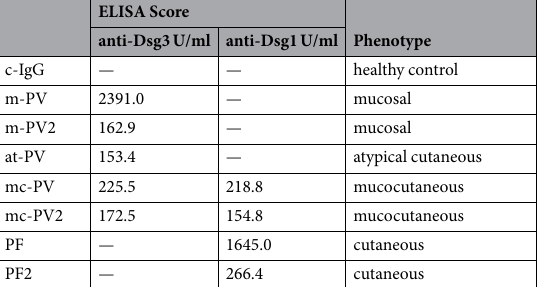
Table 1. Antibody profiles of IgG-fractions determined by Dsg1 and Dsg3 ELISA and their clinical